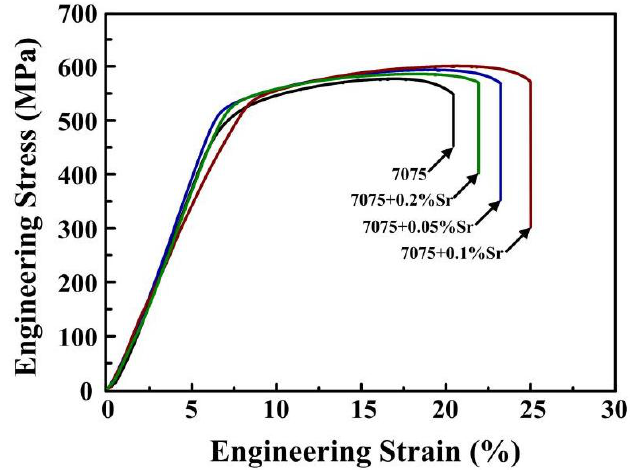
Figure 7. Engineering stress–stain curves of 7075 T6 alloy without and with different contents of Sr (wt. %).